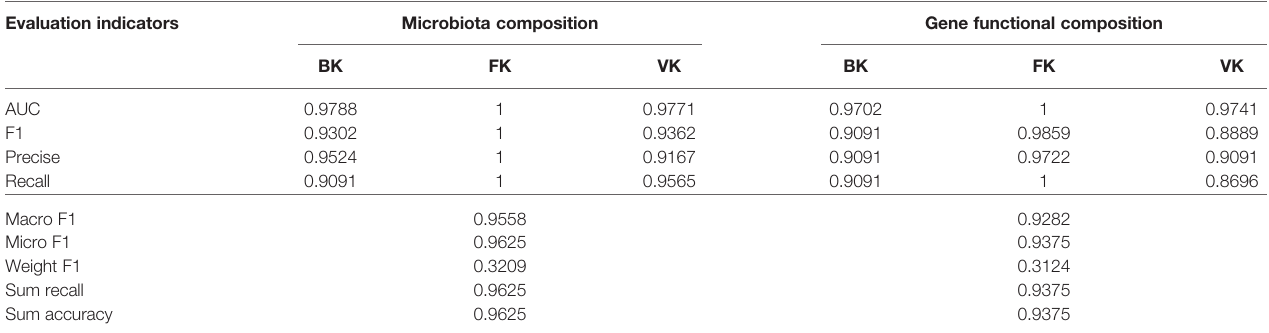
TABLE 1 | Performance evaluation of the two established models.